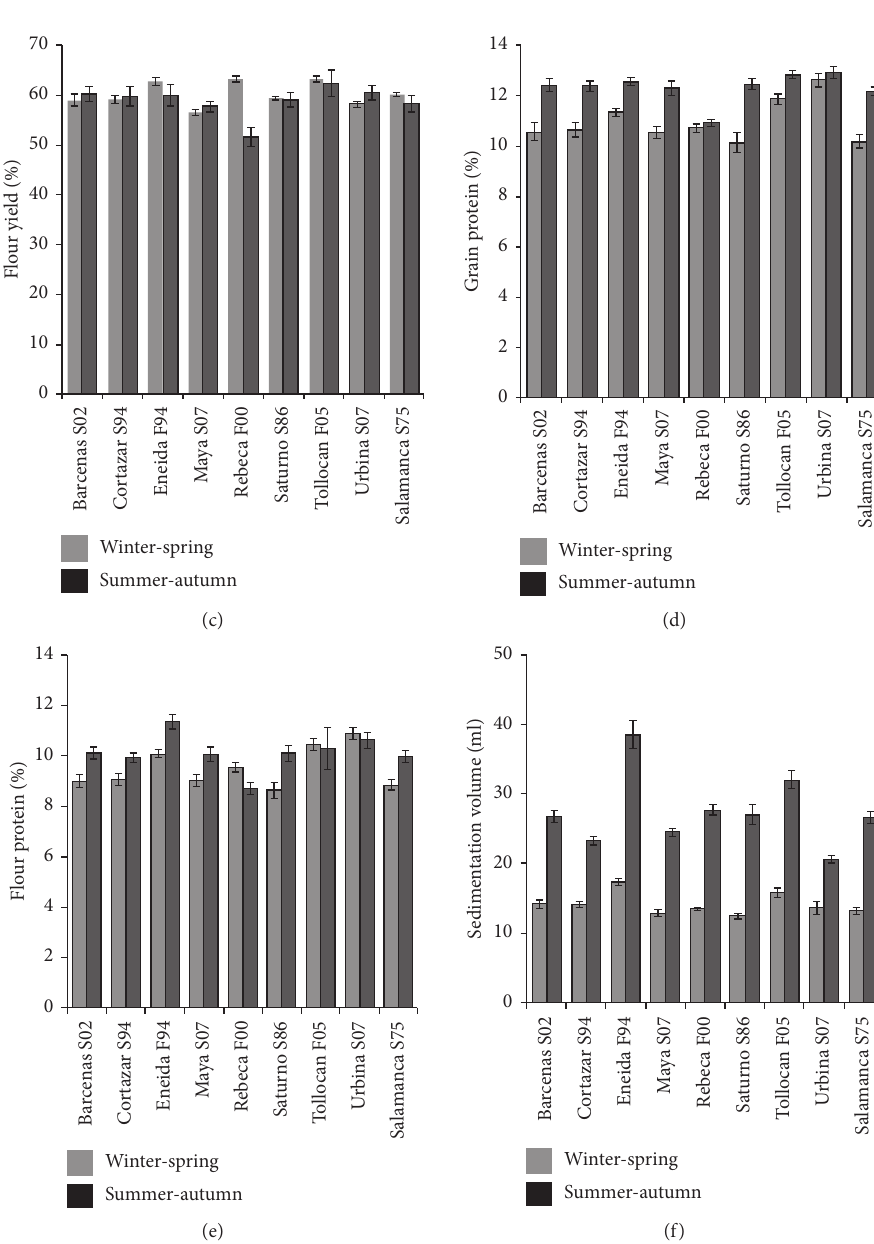
Figure 2: Mean values for variables test weight (k hL − 1 ). (a) Hardness, (b) flour yield, (c) grain protein, (d) flour protein, and (e) sedimentation volume, (f) for 9 wheat varieties grown in 2 cycles. Bars on the top of the columns indicate standard